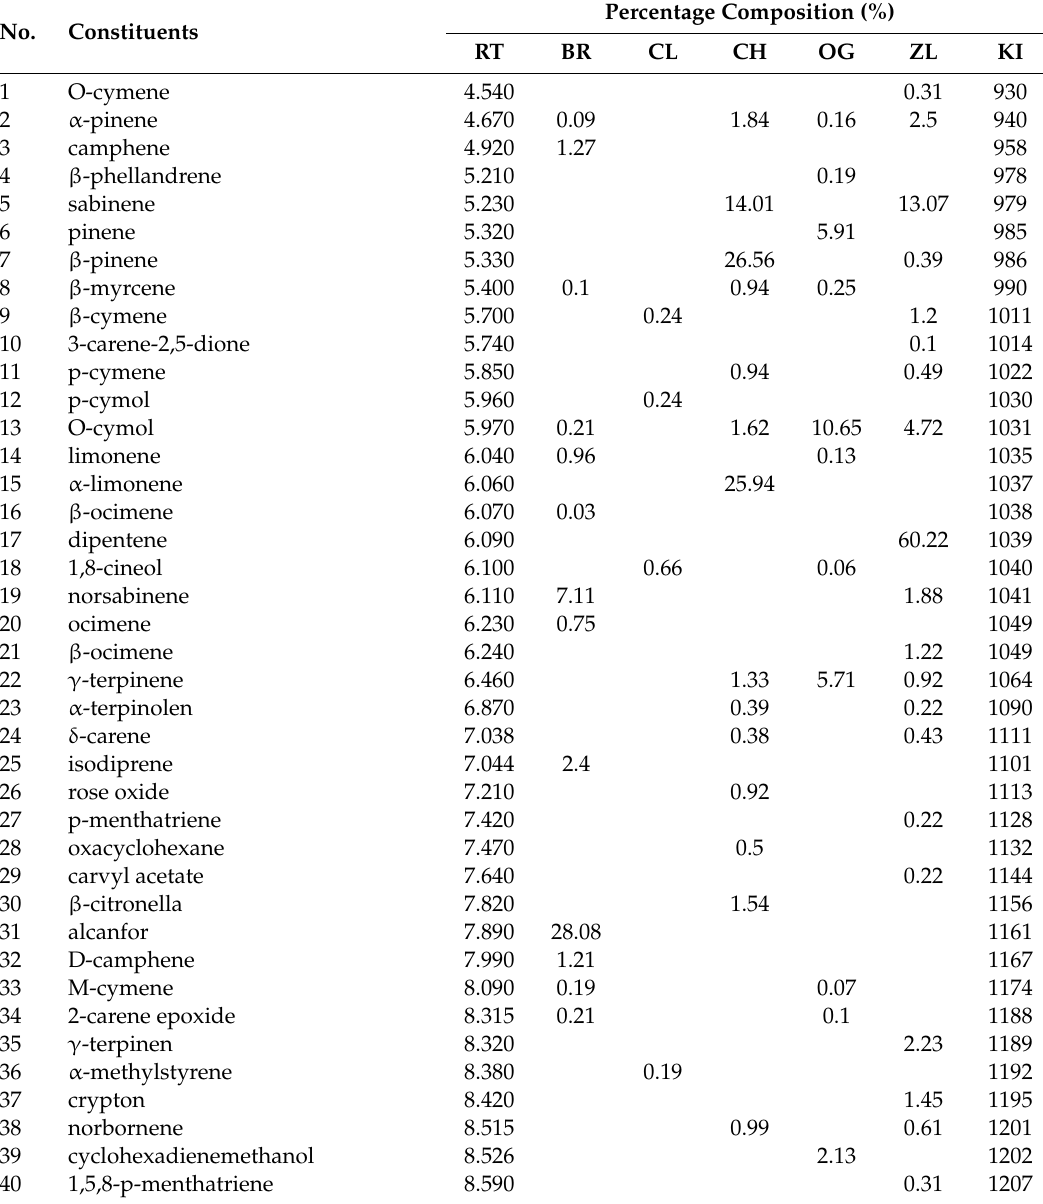
Table 3. GC-MS analysis of the essential oils